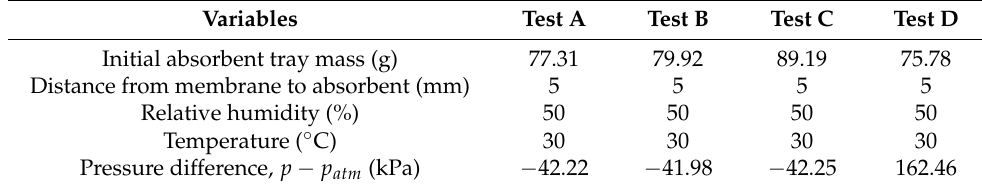
Table 1. Experimental conditions for test